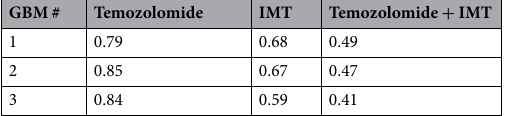
Table 1. Spectrophotometric viability (MTT) analysis in patient GBM cells. Shown are the MTT values, normalized to the respective sham control, for GBM cells obtained from 3 patients. Cells were exposed to the indicated conditions for 3 days preceding analysis. IMT was statistically superior to temozolomide in reducing GBM cell viability and the combination of temozolomide and IMT produced dramatic, highly significant anti- neoplastic effects. These data are summarized in Fig.